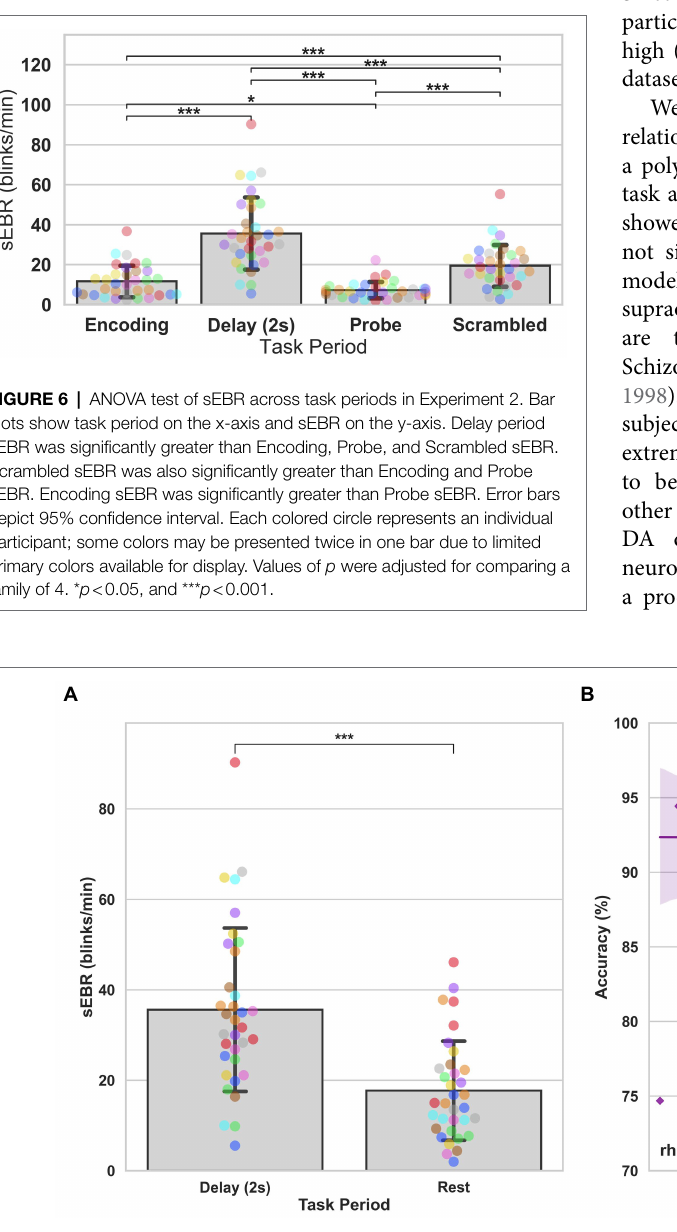
FIGURE 7 | Paired T tests between Delay period sEBR and Rest sEBR and correlation between Rest sEBR and task accuracy in Experiment 2. (A) Bar plots show task period on the x-axis and sEBR on the y-axis. Delay period sEBR was significantly higher than Rest sEBR. Error bars depict 95% confidence interval. (B) Correlation plot of sEBR during the Rest period on the x-axis and task accuracy on the y-axis. Fitted line represents linear regression model fit. Shaded region depicts 95% confidence interval. *** p <